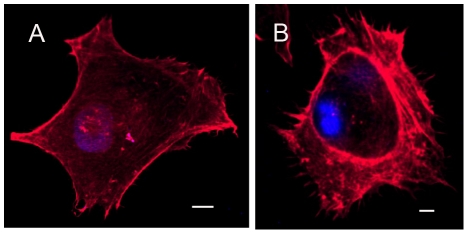
Confocal laser scanning microscope analysis of individual MCF7 (A) and pII (B) cells showing differences in both intensity and arrangement of F actin filaments visualised by phalloidin staining as described in Methods.Microspikes and lamellipodia-like structures are visible in the pII cells. Both photographs were enhanced equally by auto-contrast in Adobe Photoshop. Scale bar indicates 10 µm.